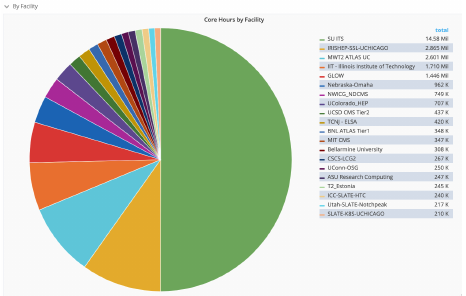
Figure 3: Backfilling the IRISHEP-SSL- UCHICAGO cluster resource with high throughput jobs from the OSG virtual orgniza- tion for a recent 90 day period in which 2.865M CPU-hours were delivered to